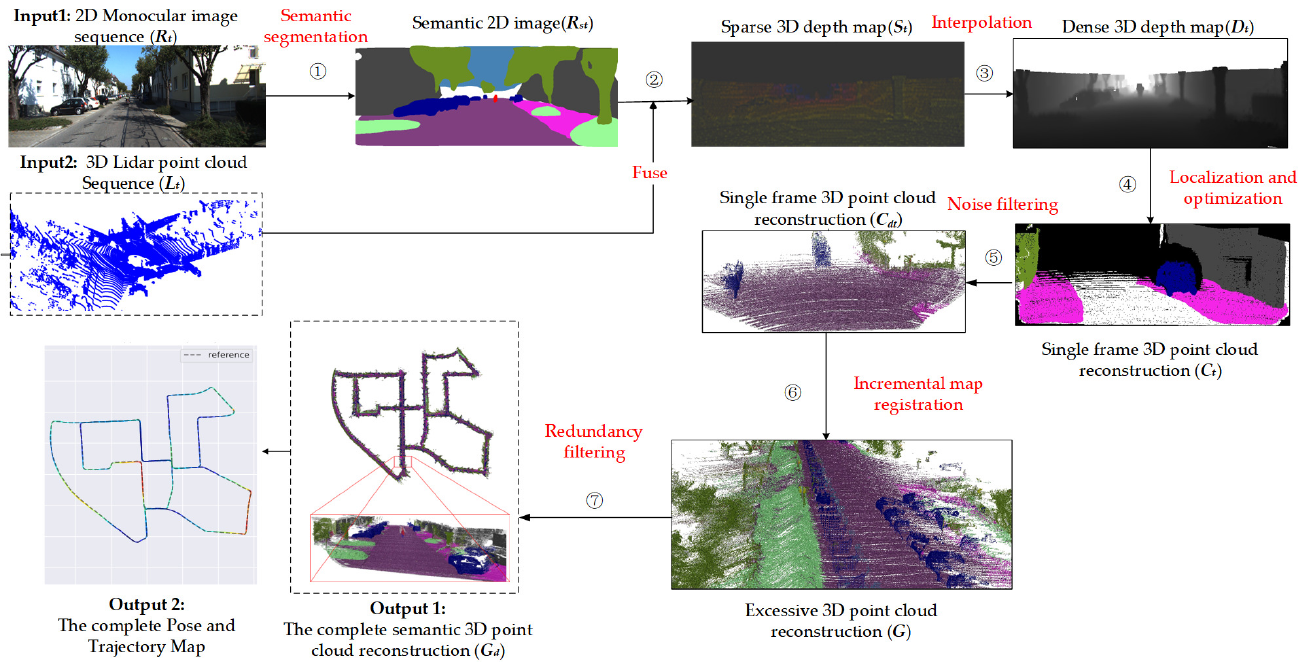
Figure 1. The overall framework of the proposed method. The overall framework of the proposed method, which corresponds to Algorithm